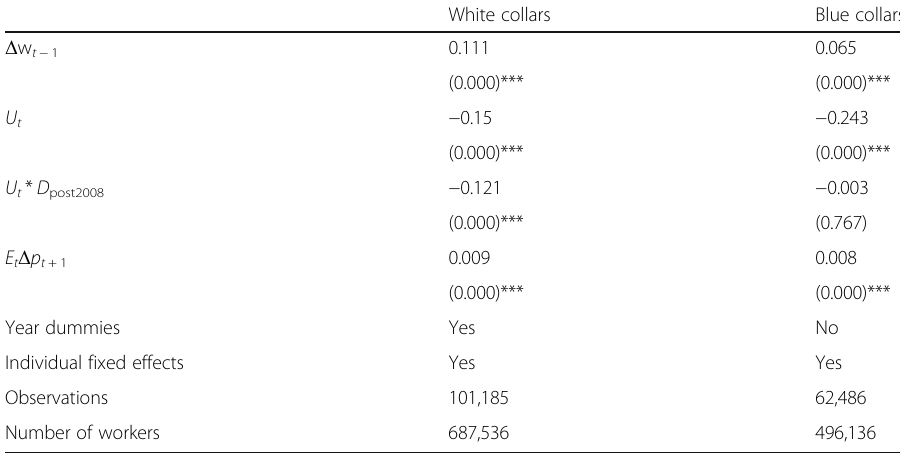
Table 5 Wage Phillips curve in Italy: individual estimates; job stayers — blue and white collars ( p values in brackets) Δ w t − 1 0.111 0.065